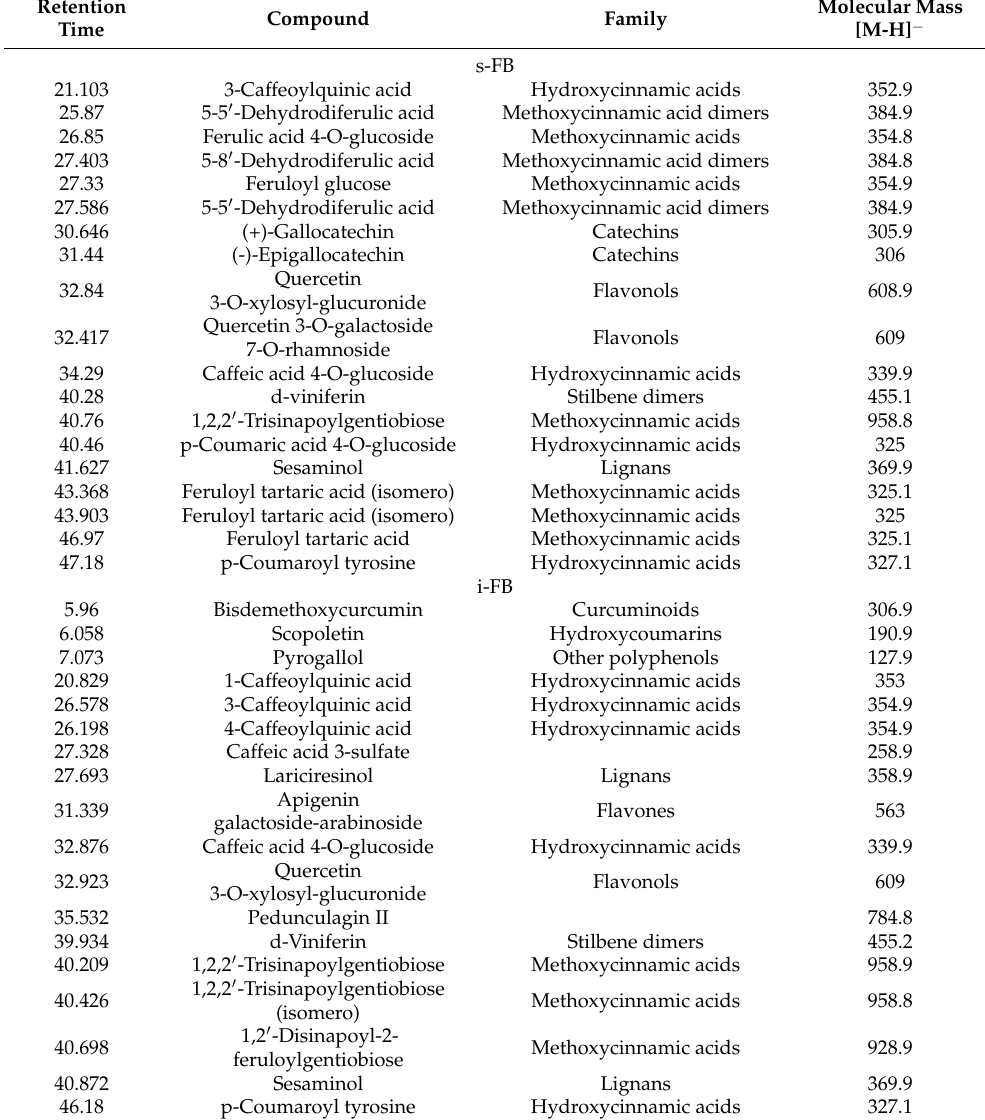
Table 3. Phenolic compounds identified on day 6 of